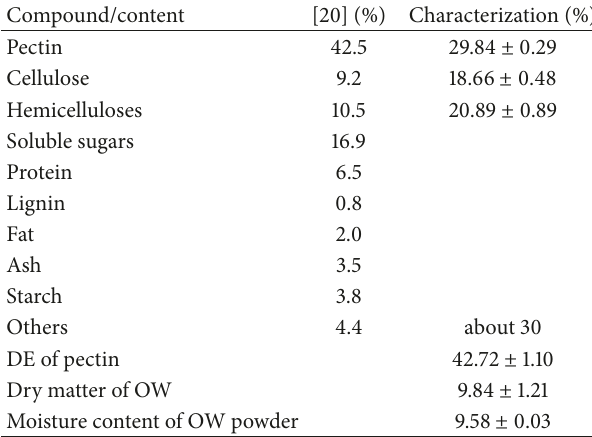
Table 1: Chemical composition of OW according to the literature [20] and the results obtained from material characterization (% (w/dry w)).